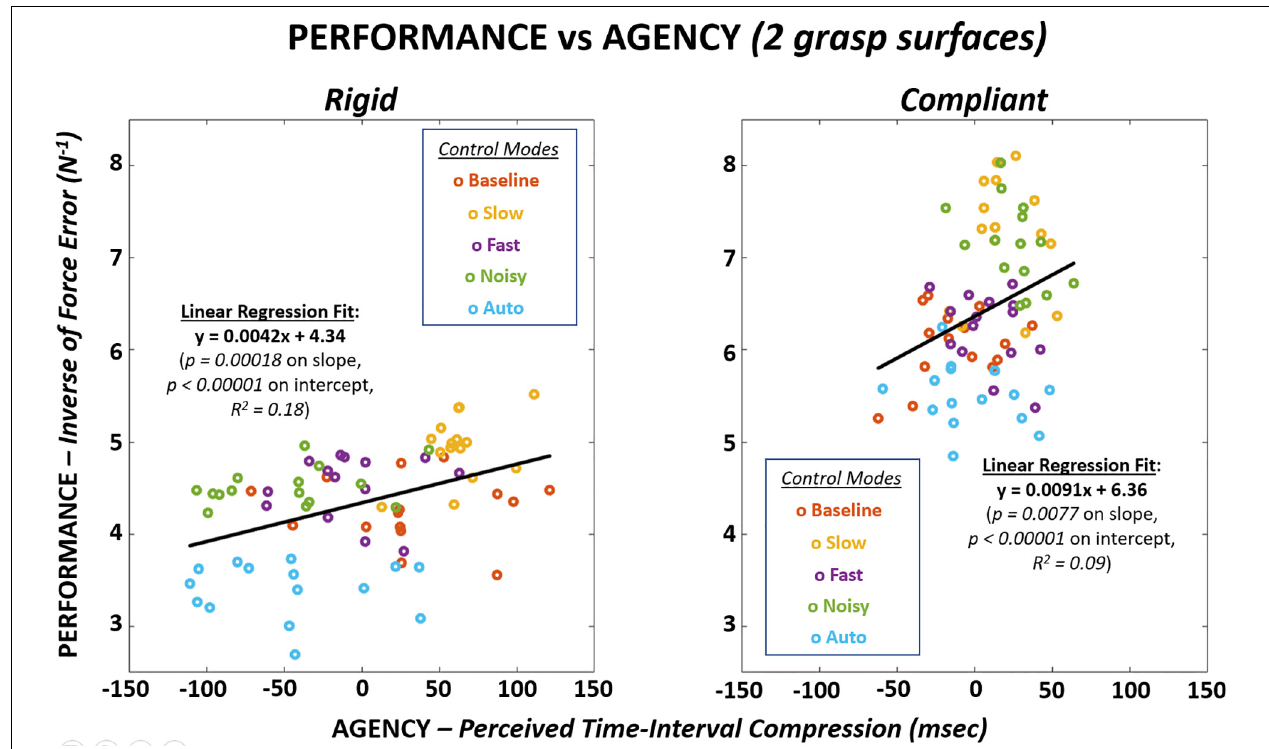
FIGURE 4 | Performance of precision pinch grasp displayed against implicit agency across control modes on both rigid (LEFT) and compliant (RIGHT) grasp surfaces. Each point indicates a participant-average for that control mode and surface. Performance positively measured as inverse of average tracking error to target force ramp. Implicit agency positively measured as underestimation of time-intervals between completion of ramp task and subsequent sound beep.